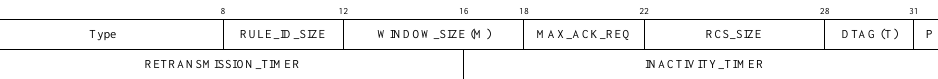
Figure 11. ICMPv6 SCHC parameter option.